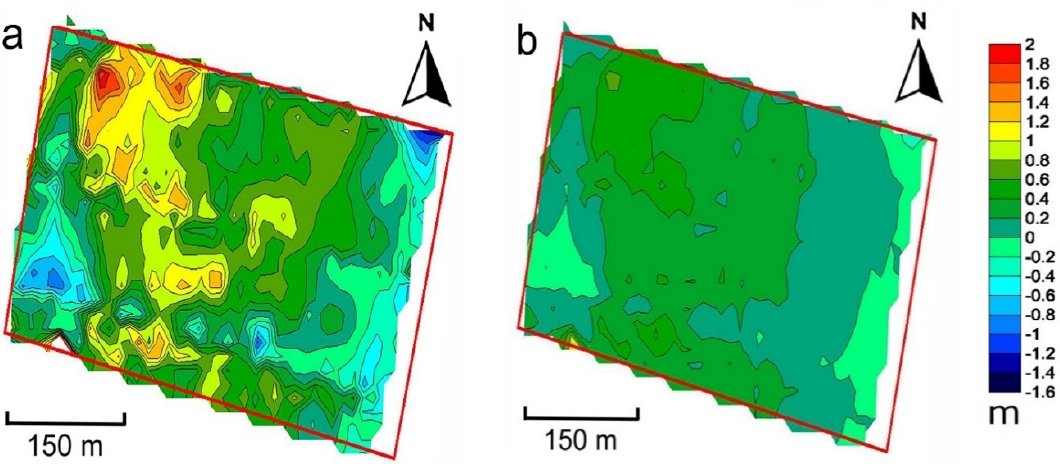
Figure 14. Di ff erences in elevation maps using satellite-Stumpf- ( a ) and UAV-Lyzenga-derived ( b ) bathymetries and real survey in the study area.